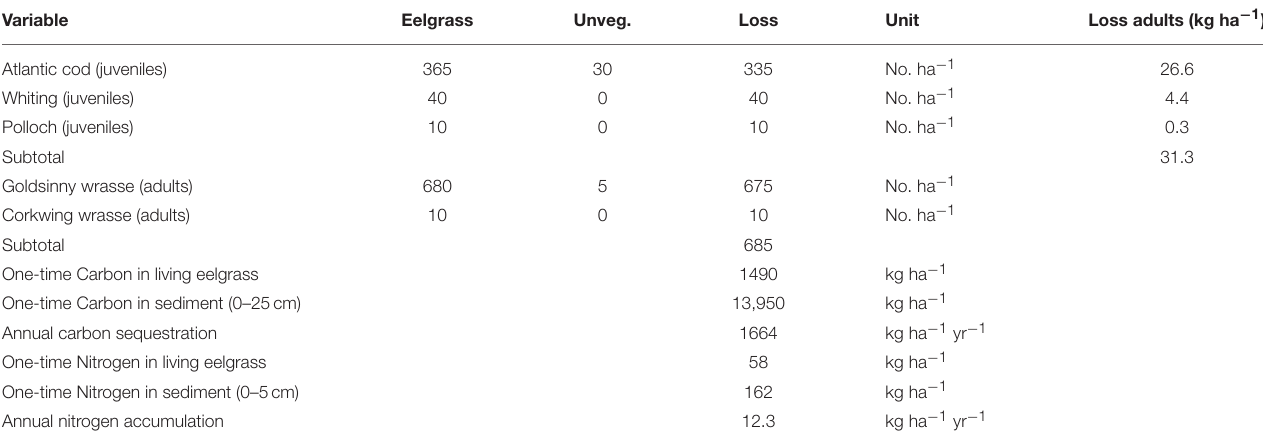
TABLE 2 | Estimated ecological endpoints related to commercial fish, carbon and nitrogen per hectare of lost